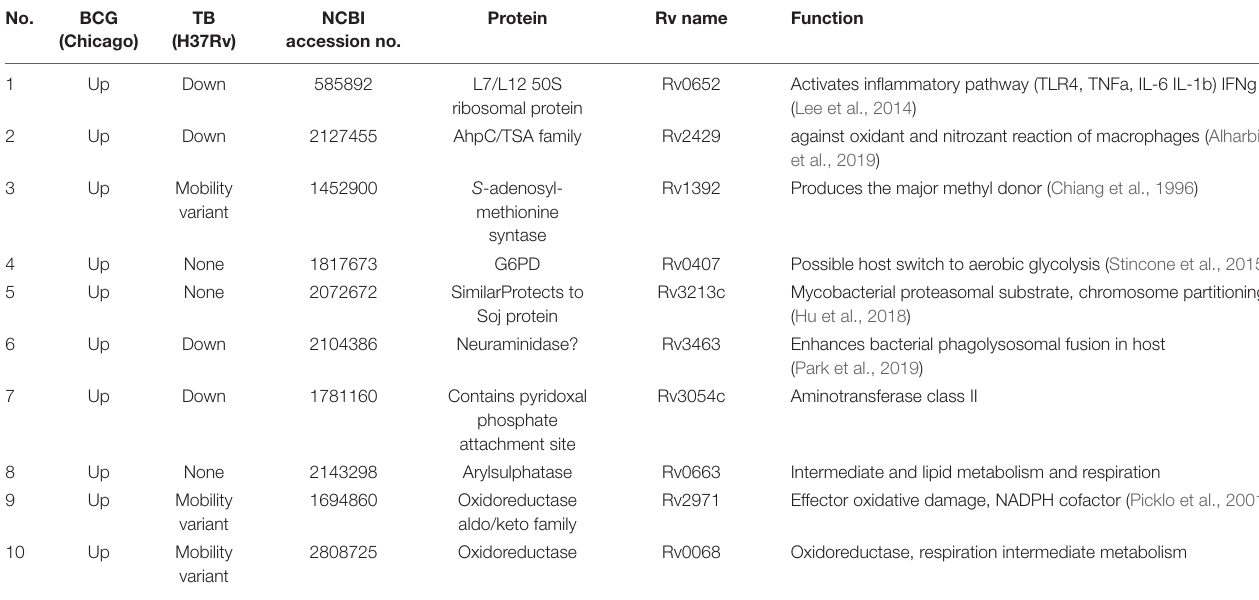
TABLE 1 | Bacillus Calmette–Guérin proteins overexpressed vs. mycobacterium Mtb proteins.